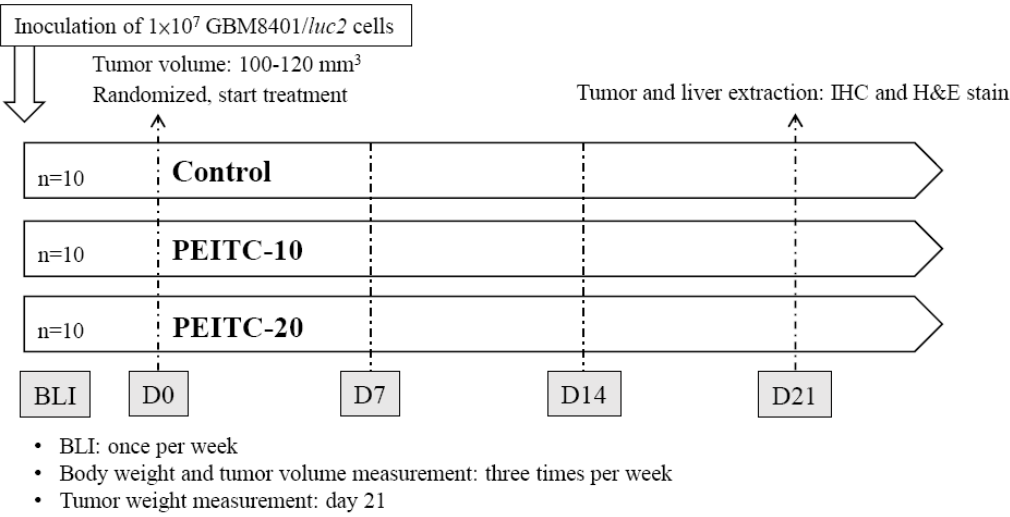
Figure 5. Experimental design for the treatments of human GBM 8401-bearing mice. Each mouse was injected with 1 × 10 7 GBM 8401/ luc2 cells. After the tumor volume reached 100–120 mm 3 , mice were randomized into three different treatment groups (n = 10 per group). PEITC (10, 20 μ mole/100 μ L PBS) was administered daily by gavage. All mice were sacrificed 21 days after treatments. IHC: